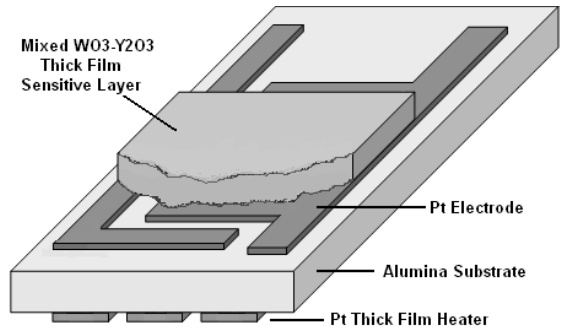
Figure 1. Configuration of the sensor